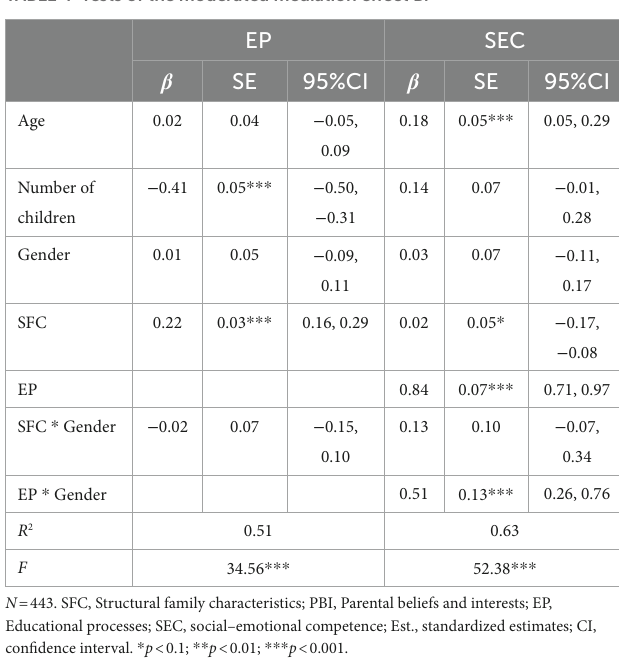
TABLE 4 Tests of the moderated mediation effect B.